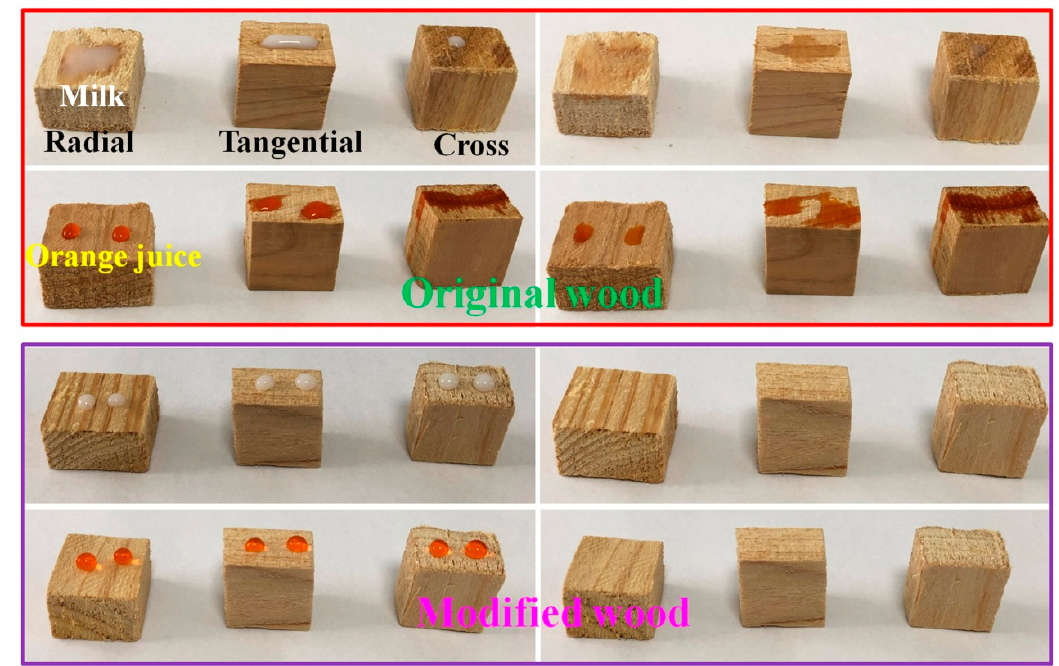
Figure 9. Anti-fouling property of original and modified woods to milk and orange juice.